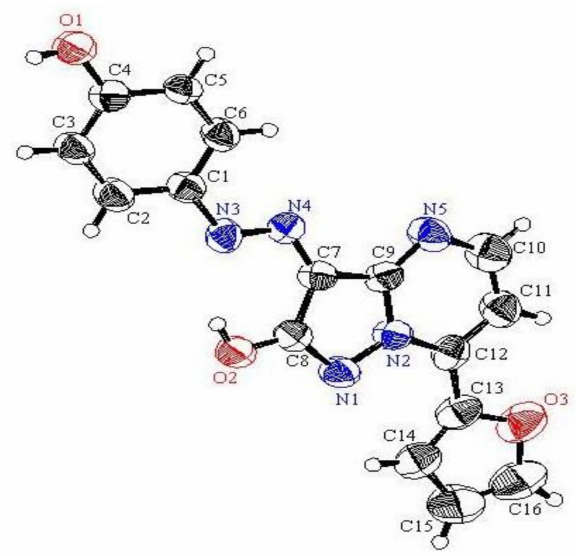
Figure 5. ORTEP of compound 13c . Table 1. Yields of Compounds 4 , 6 , 9 and 13a – d